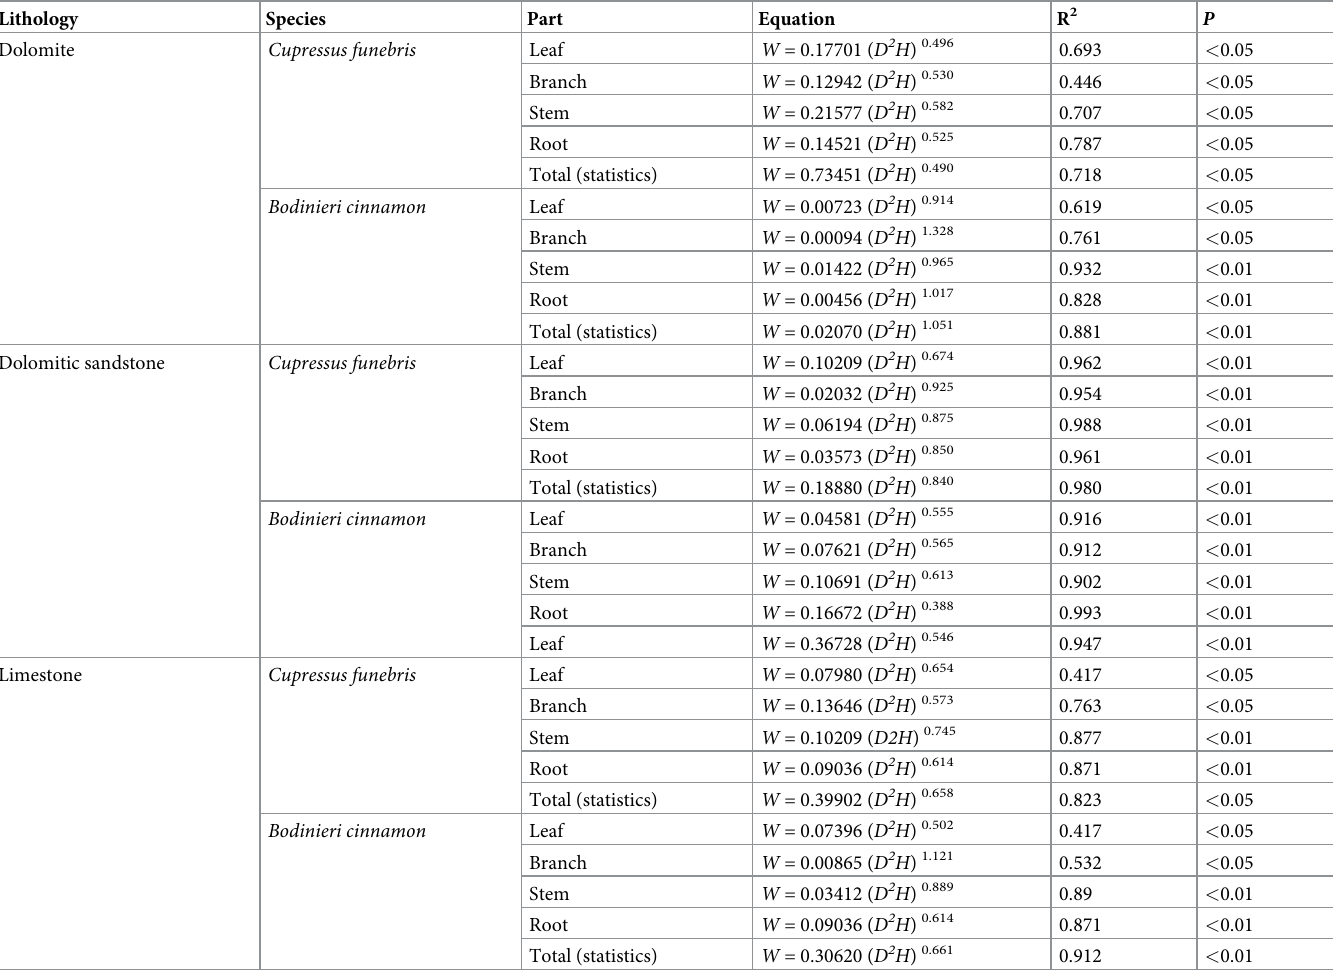
Table 2. Relationship of the biomass of each part (kg) ( W ) of the dominant species with diameter at breast height (cm) ( D ) and tree height (m) ( H ) under different